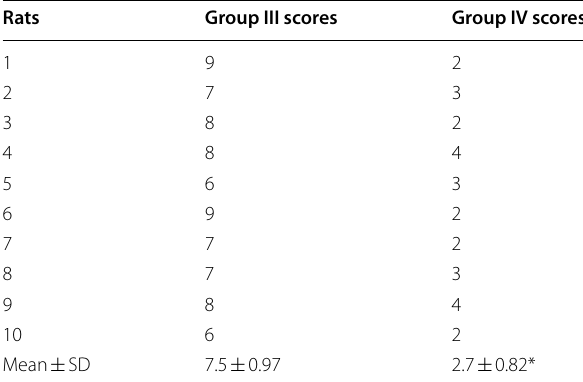
Table 5 Total scores of histopathological lesions in rat lungs in the different studied groups